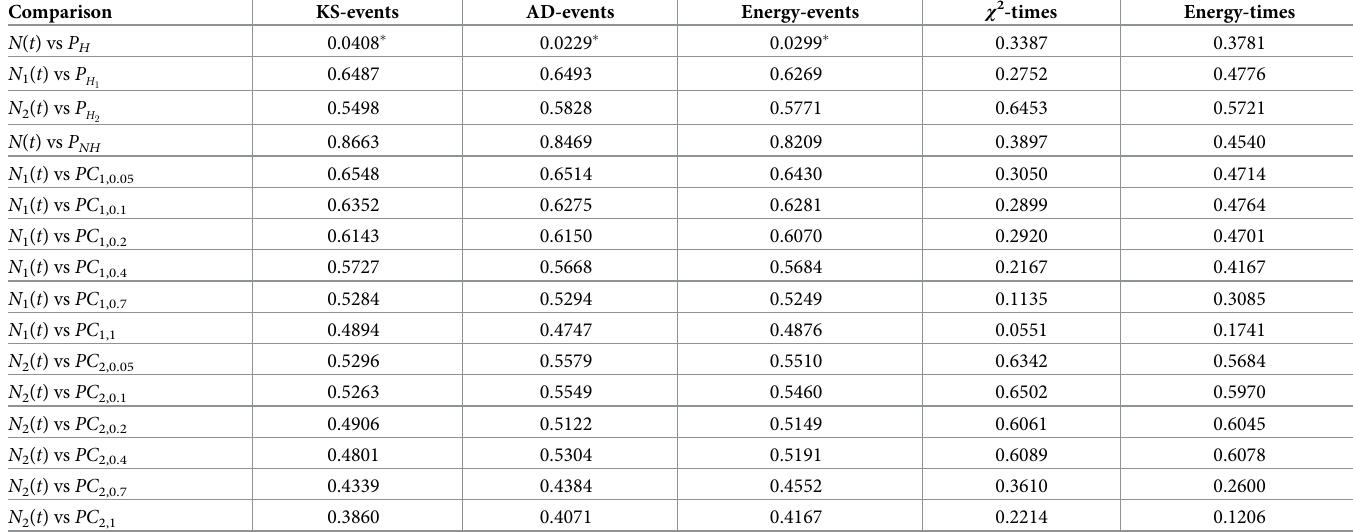
Table 8. Median p-values over 500 simulations for different homogeneity tests over the distribution of events and inter-arrival times. Significant differences ( α = 0.05) are identified with an asterisk ( � ).